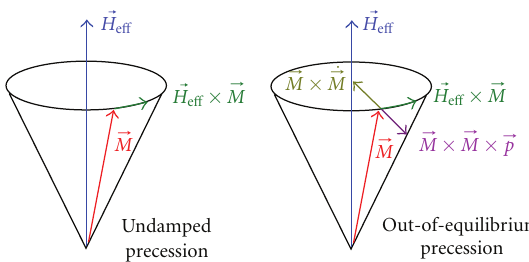
Figure 3: Schematic representation of undamped (in the absence of both Gilbert and current-induced damping) and out-of- equilibrium (in the presence of both Gilbert and current-induced damping) precessions. In this latter case, a limit cycle is described as well since the torques due to the intrinsic dissipation and the spin- transfer-induced one (for a proper intensity and direction of the current) balance each